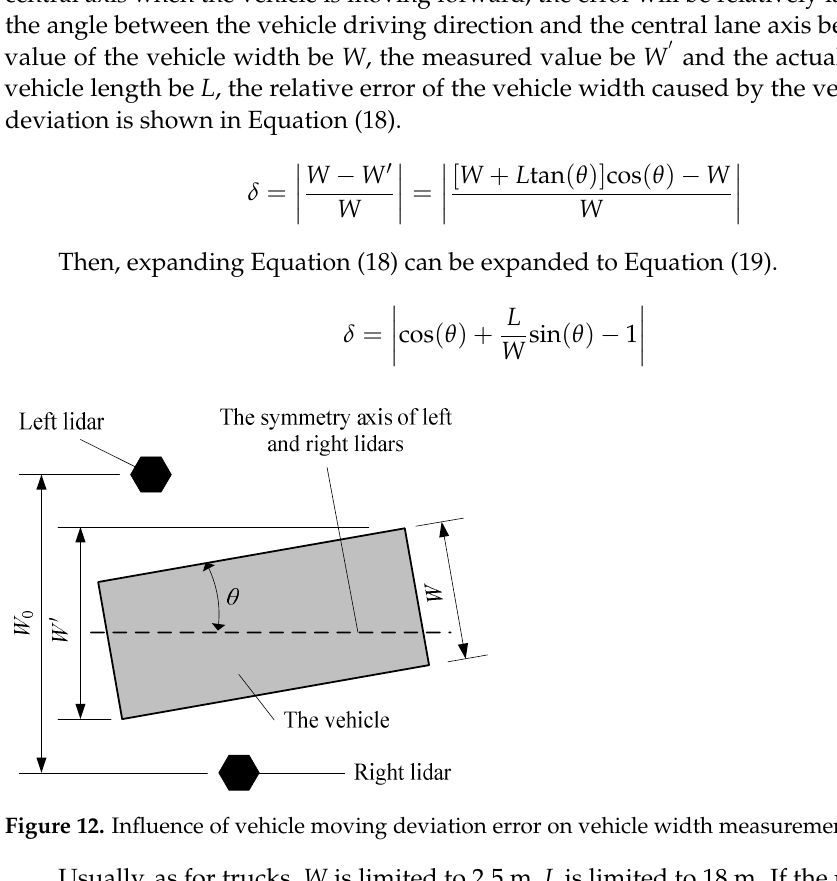
Figure 13. Average error of vehicle width according to algorithm combination in Table 1.